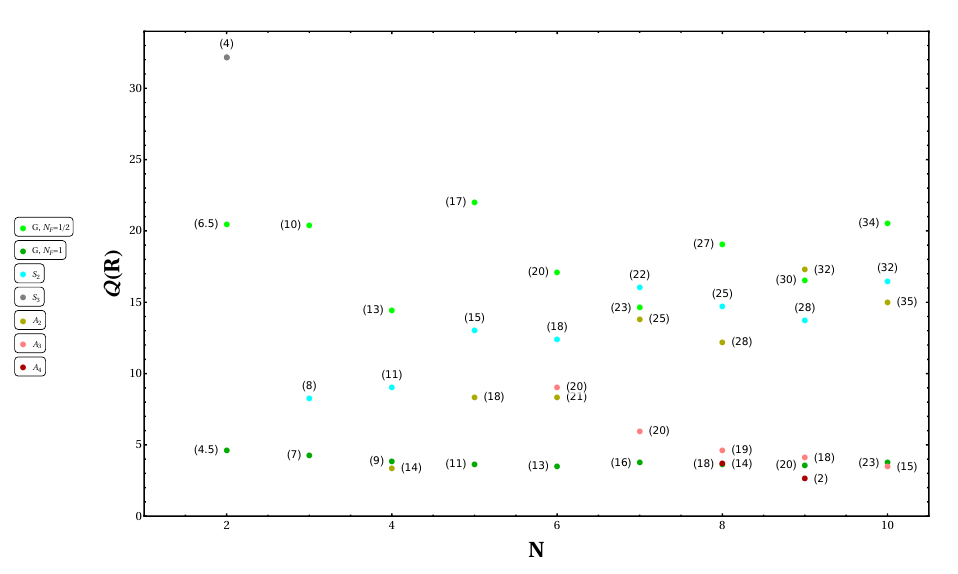
( R ) = ⇤ χ SB R / ⇤ χ SB F against the number of colours in theories with the minimal Figure 2. Plot of Q number of fermions in the higher dimensional representation (either 1 or 1 / 2 for real representations) and N F in the fundamental representation. N F has been tuned to maximize ( R ) and its value is next to f f Q the point. We have used red for the fundamental, green for the adjoint, cyan for the rank-2 symmetric, gray for three-rank symmetric, gold for the rank-2 antisymmetric, pink for the A 3 , maroon for the A 4 , and blue, orange, black for the R 1 , 2 , 3